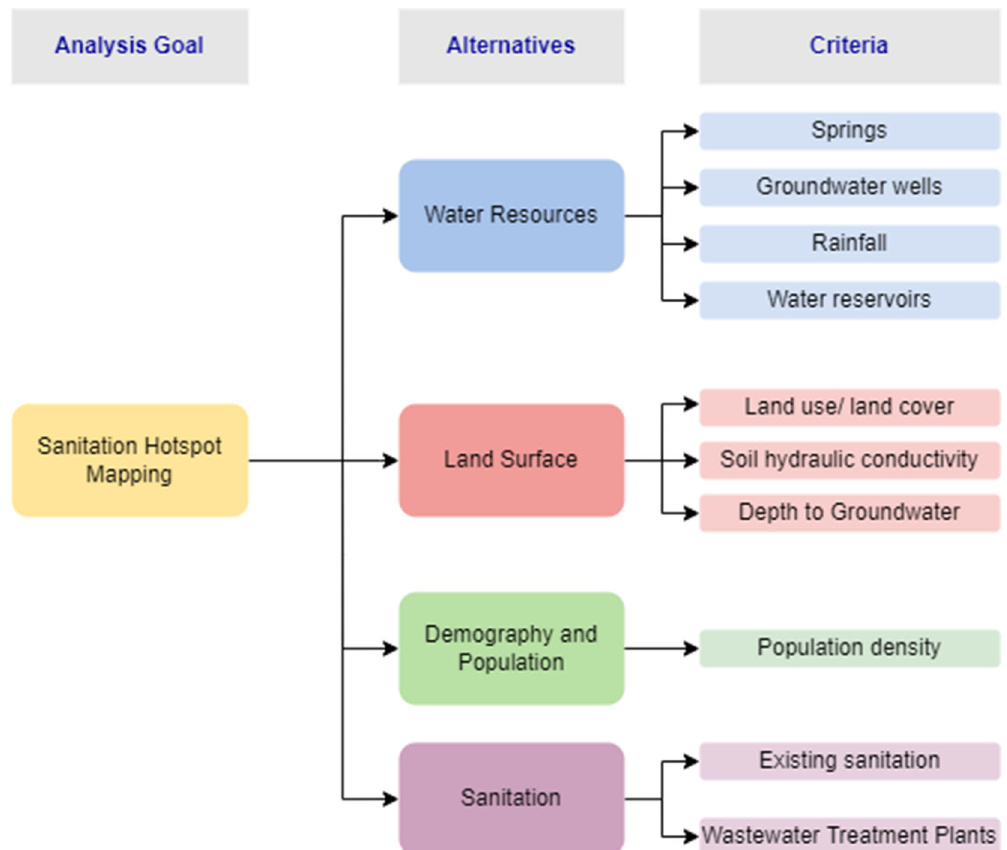
Figure 2. Hierarchy model used for sanitation hotspot mapping.